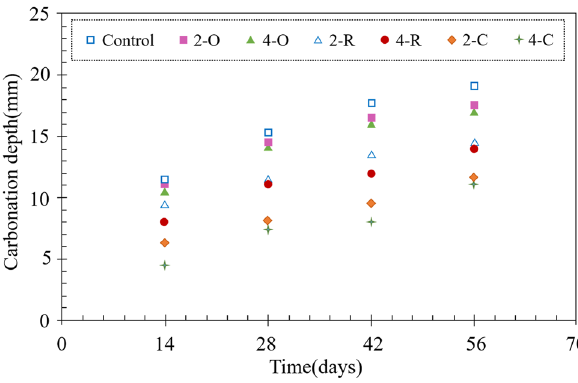
Figure 6: Carbonation depth of the designed concrete with LDHs materials at di ff erent curing days [ 93 ] .